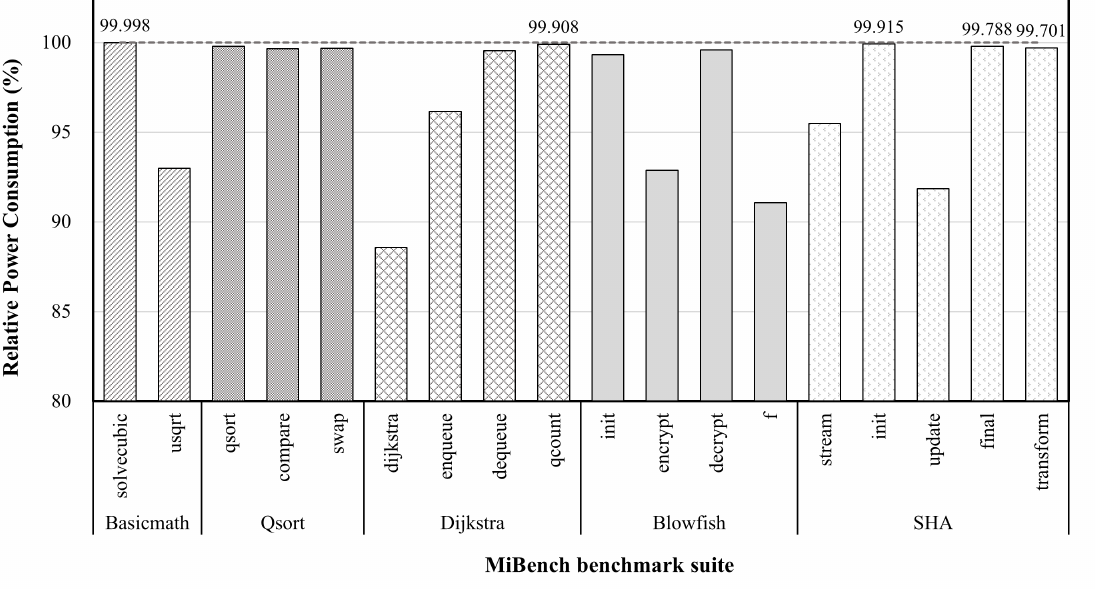
Figure 9. Relative power consumption of benchmark